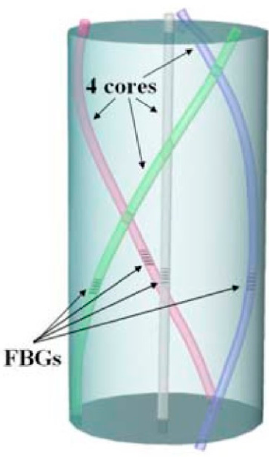
Figure 18. Configuration of four-core twist-biased FBGs [144].